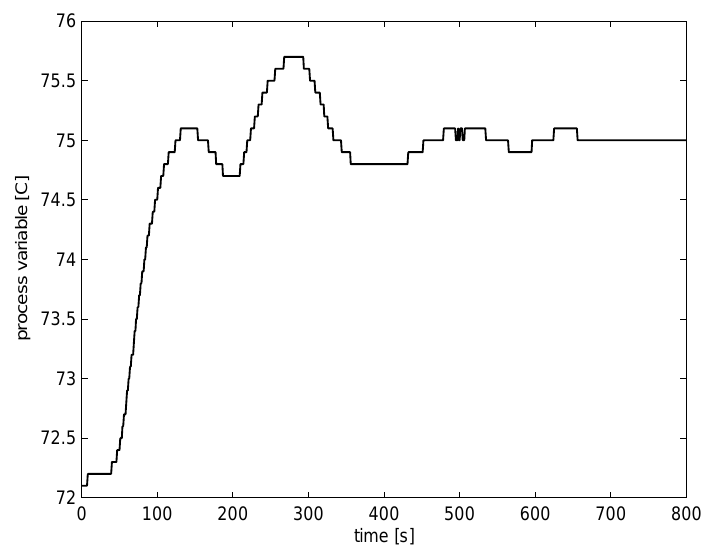
Figure 4. Set-point step response after the PID controller retuning in the temperature control